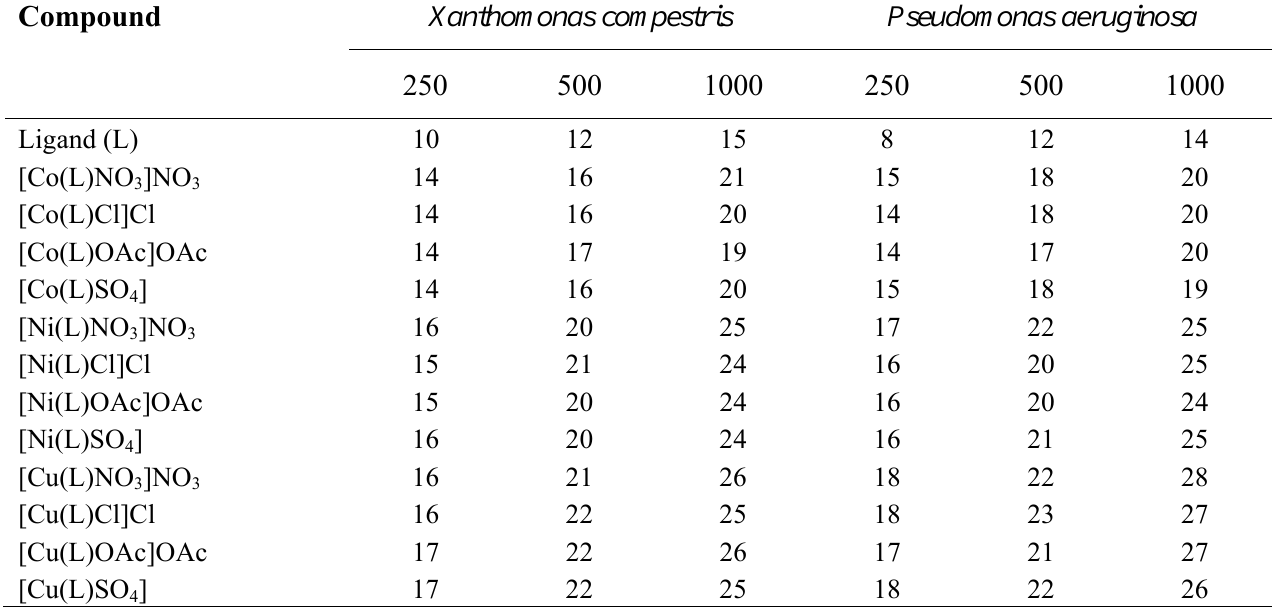
Table 7. Antibacterial activity data of